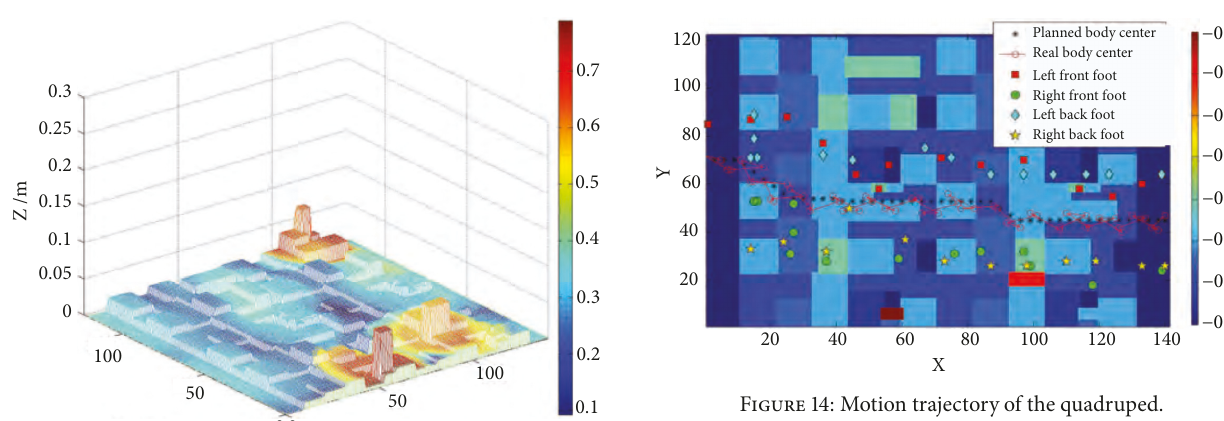
Figure 14: Motion trajectory of the quadruped. distance and walking safety. Figure 13 shows path of body center searched with two kinds of parameters, 𝛽 𝑑 = 1, 𝛽 𝑐 = 5 and 𝛽 𝑑 = 1, 𝛽 𝑐 = 10 , respectively, where color stands for the cost value of the